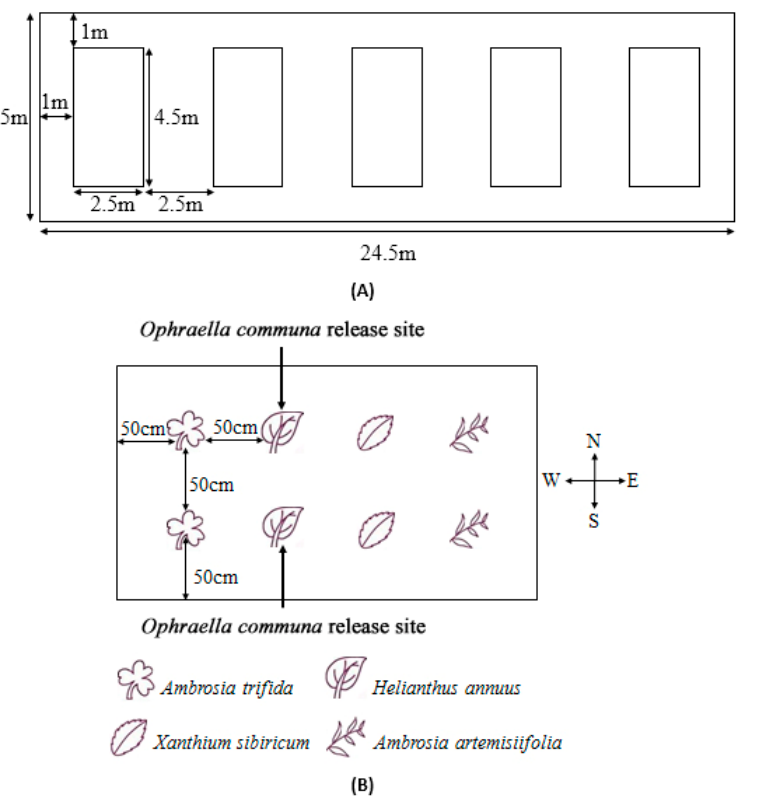
Figure 1. ( A ) Arrangement of experimental plots, ( B ) planting pattern, and Ophraella communa re- lease sites in each plot. sites in each